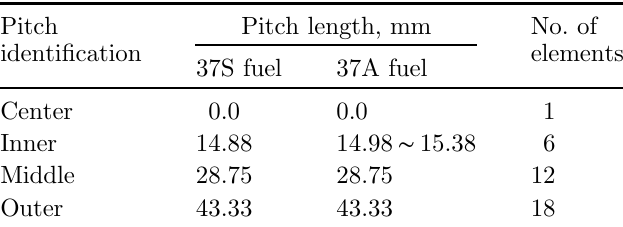
Fig. 1. The con fi guration of the CANDU fuel channel with a 37- element fuel bundle. Table 1. Pitch lengths of the 37S and 37A fuel